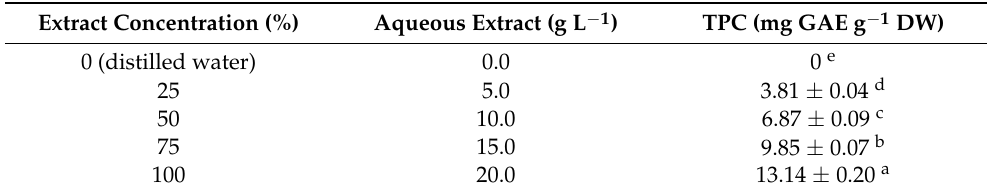
Table 1. Total phenolic content (TPC) in different solutions obtained from 2% ( w / v ) hemp leaves aqueous